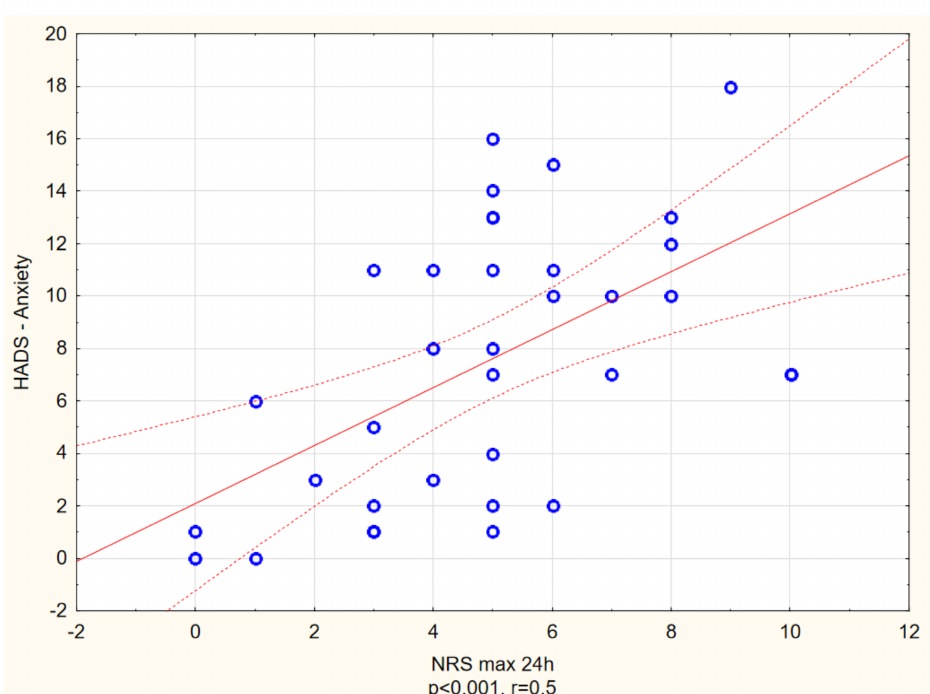
Figure 6. Spearman’s correlation analysis revealed a significant positive link between maximal itch intensity measured with Numerical Rating Scale (NRS) and level of anxiety measured with Hospital Anxiety and Depression Scale (HADS) (R = 0.5, p <